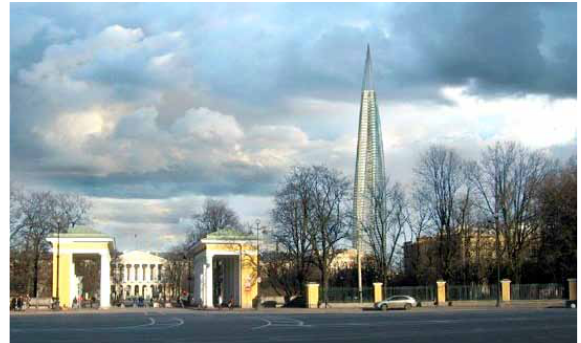
fig. 5. okhta Centre (known until March 2017 as Gazprom City) would ruin the city’s